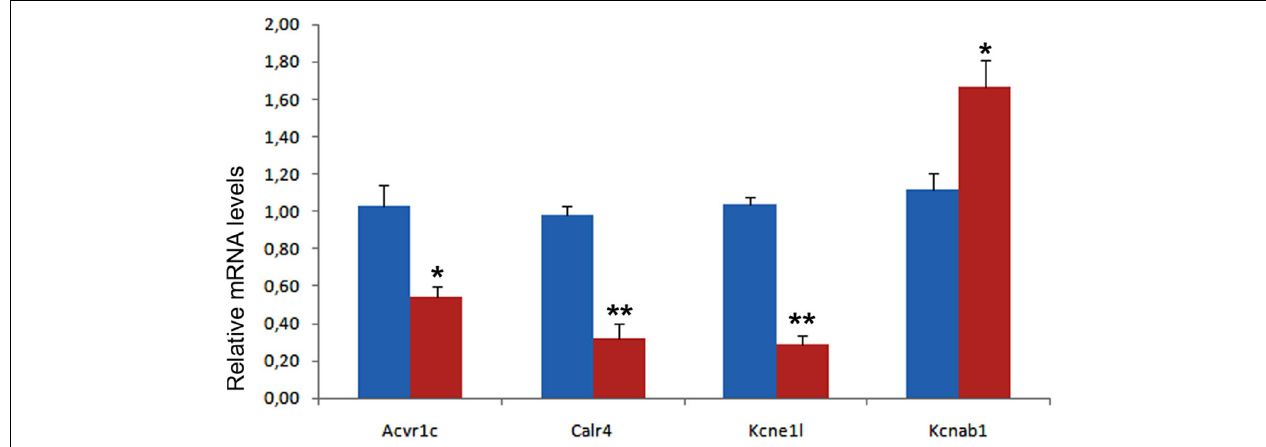
FIGURE 8 | Validation of four differentially expressed genes in control (blue) and mutant (red) hearts from E13.5 embryos. Each PCR reaction was carried out in triplicate and repeated in at least three distinct pooled biological samples. ** p < 0.01, * p < 0.05, Student’s t